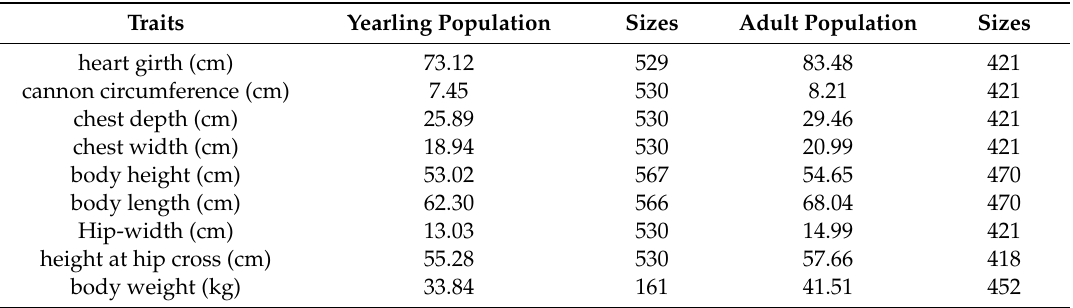
Table 2. Mean values of growth traits in yearling and adult Shaanbei white cashmere goats. Traits